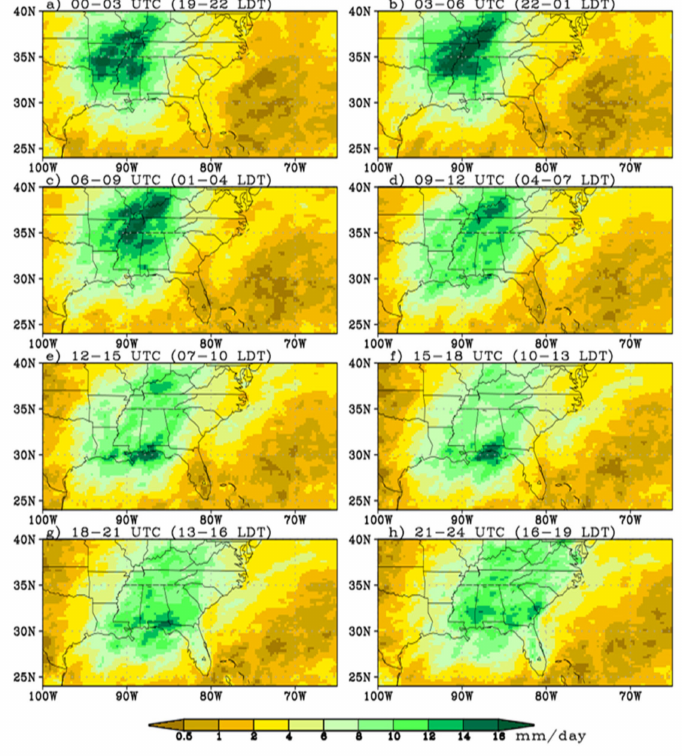
Figure 9. Same as Figure 7, but for